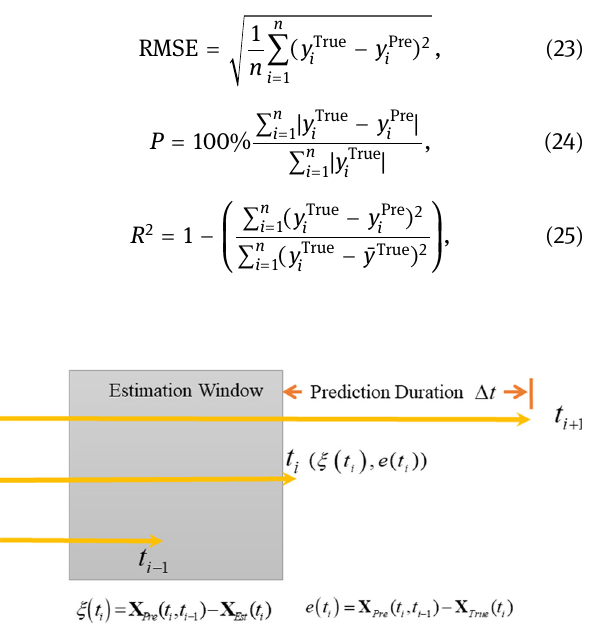
Figure 2: Illustration of learning and target variables.